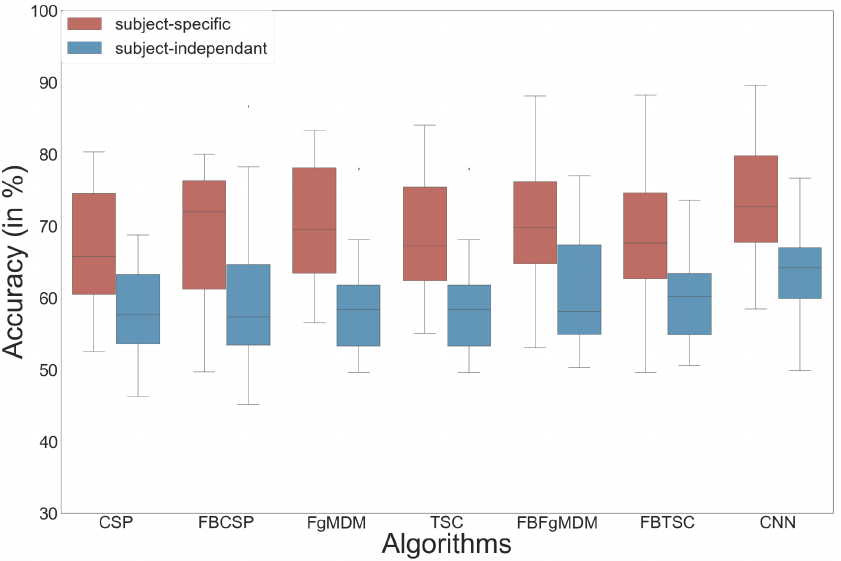
Figure 8. Classification accuracy of each algorithm on the workload data, in both subject-specific and subject-independent